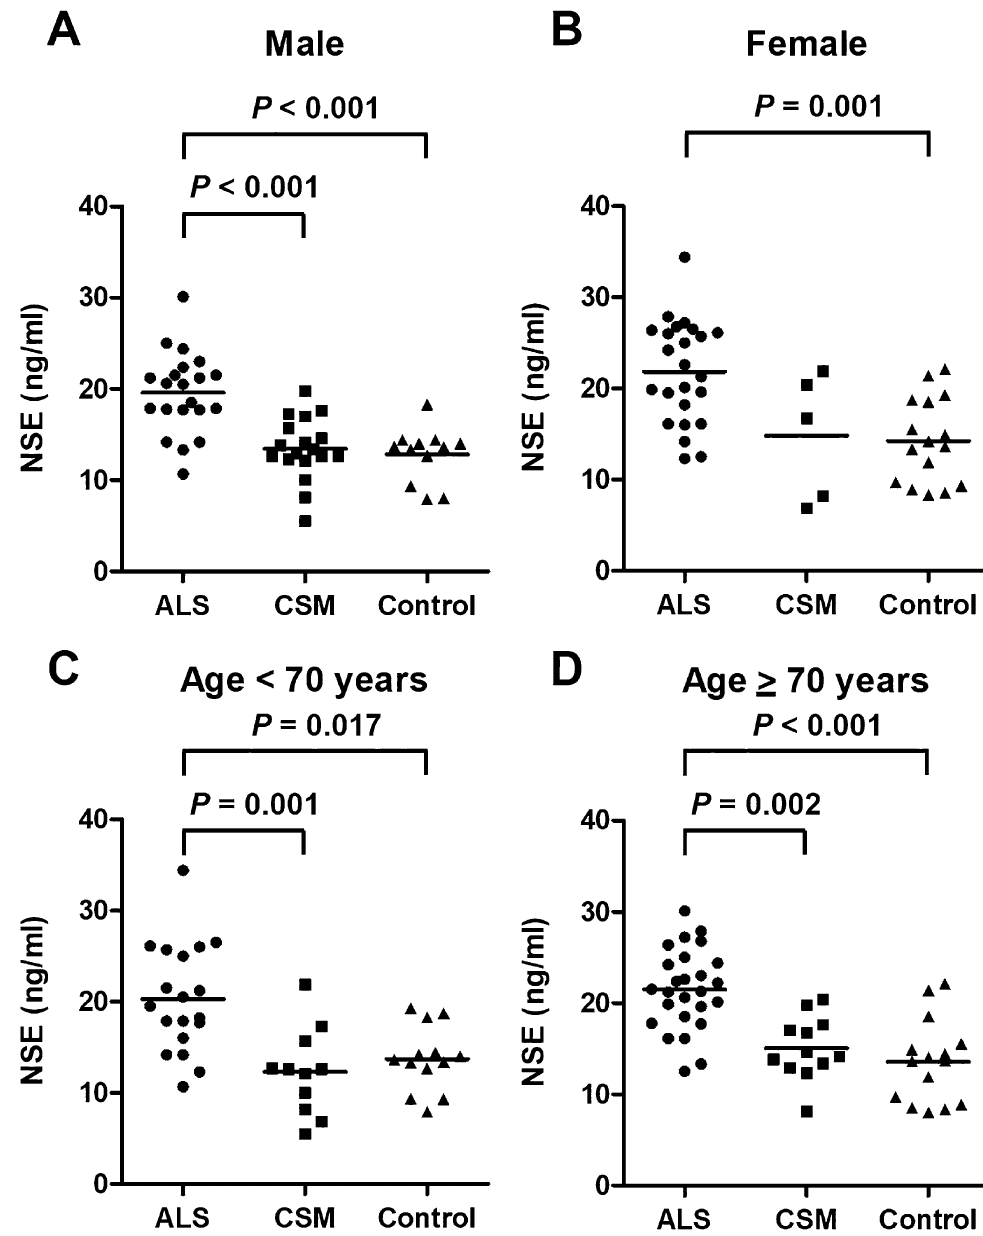
Figure 2. CSF NSE levels of the ALS, CSM, and control groups based on the subgroup analyses of ( A ) male and ( B ) female patients, ( C ) those aged < 70 years, and ( D ) those aged ≥ 70 years. The solid line represents the mean CSF NSE levels of each group. ALS amyotrophic lateral sclerosis, CSF cerebrospinal fluid, CSM cervical spondylotic myelopathy, NSE neuron-specific